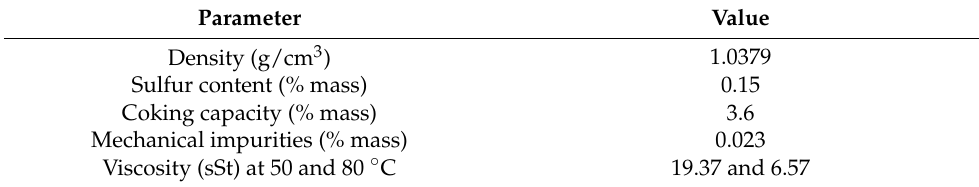
Table 1. Physicochemical parameters of original low-sulfur gasoil.